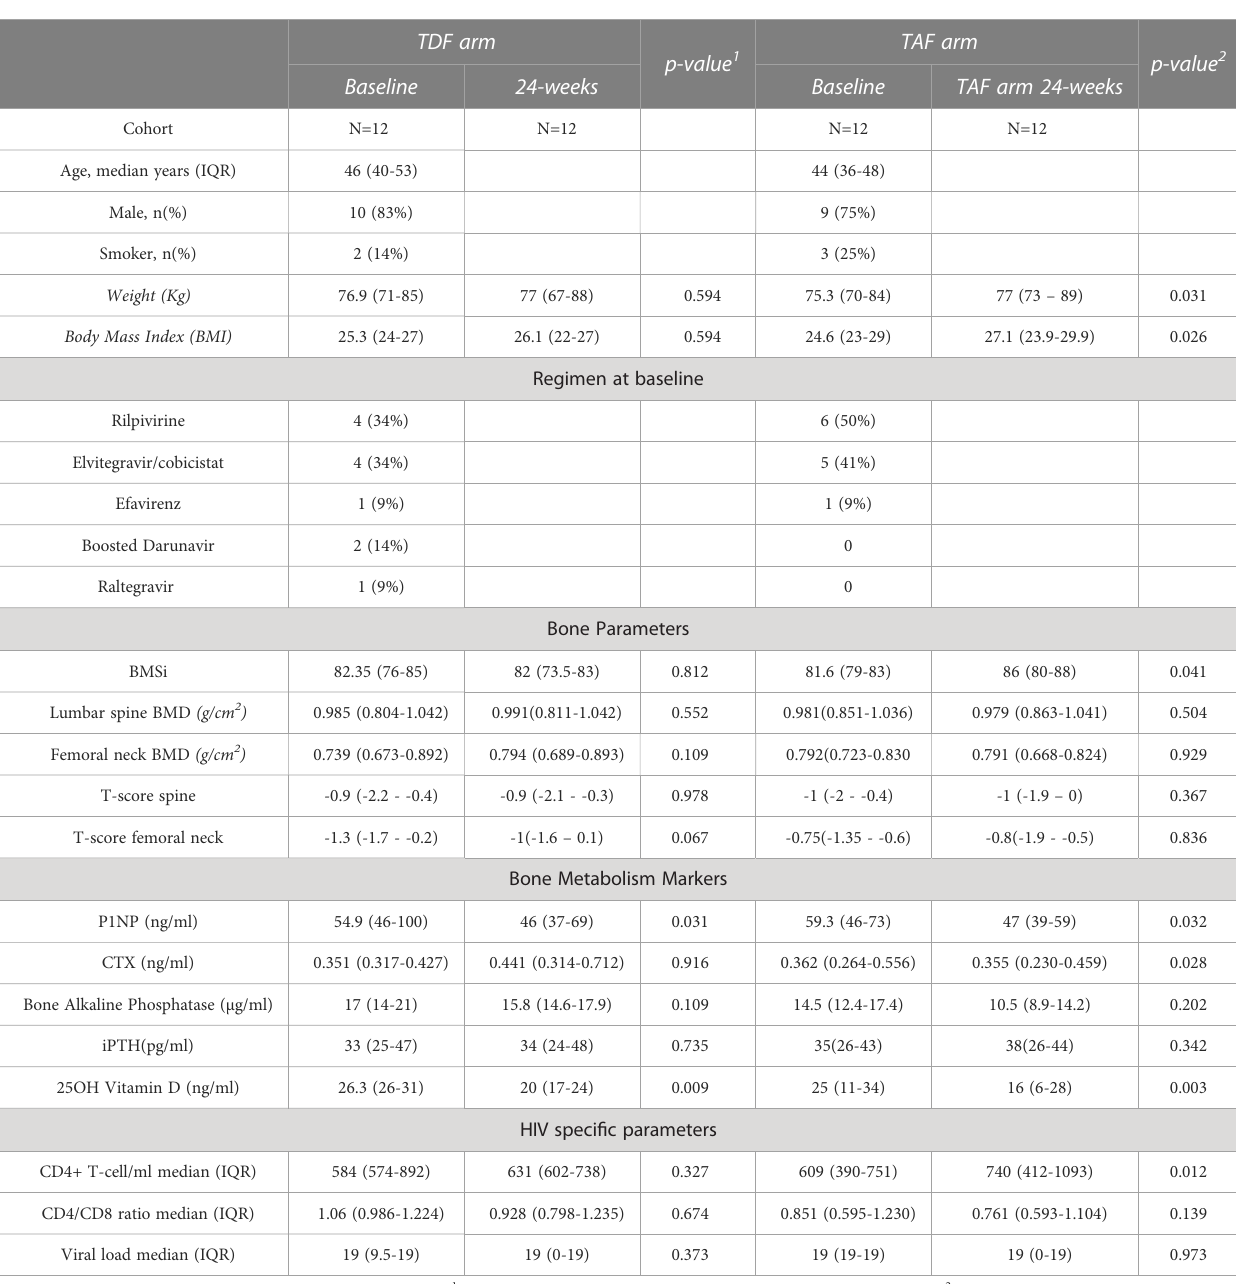
TABLE 1 Patient characteristics and bone health parameters before and after